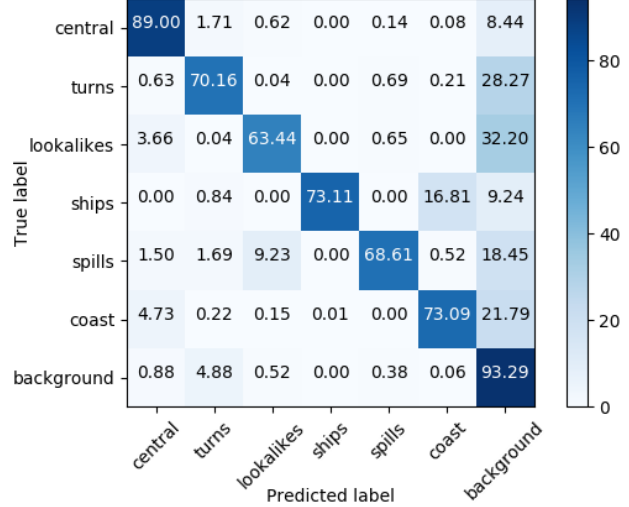
Figure 7. Normalized confusion matrix calculated for the seven classes considered at the pixel level. Rows show the current label and columns the prediction given by the specific CMSAE network for the class